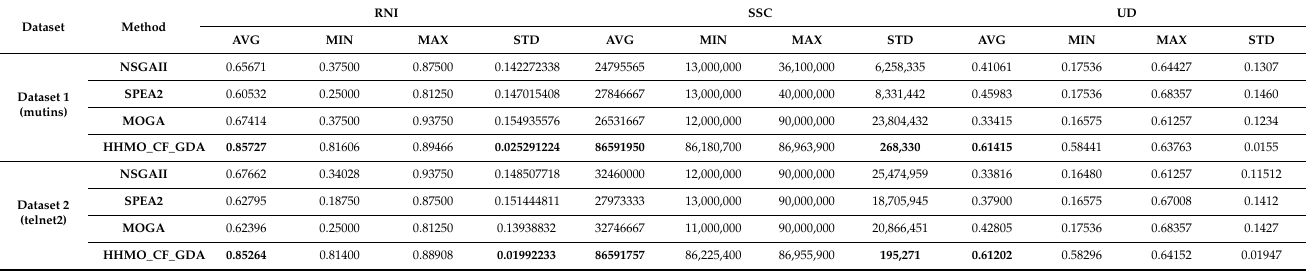
Table 7. Average performance of HHMO_CF_GDA compared to low-level heuristics on the mutins and telnet2 datasets with respect to the ratio of non-dominated individuals (RNI), size of space covered (SSC), and uniform distribution (UD).